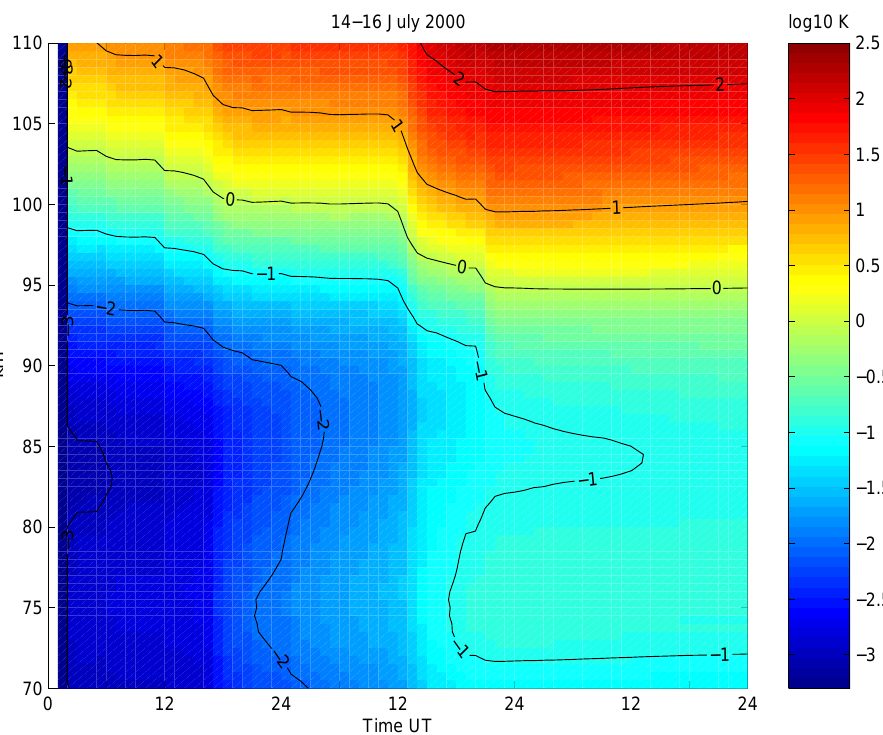
Fig. 11. Temperature enhancement between 70–110km altitude due to Joule and particle